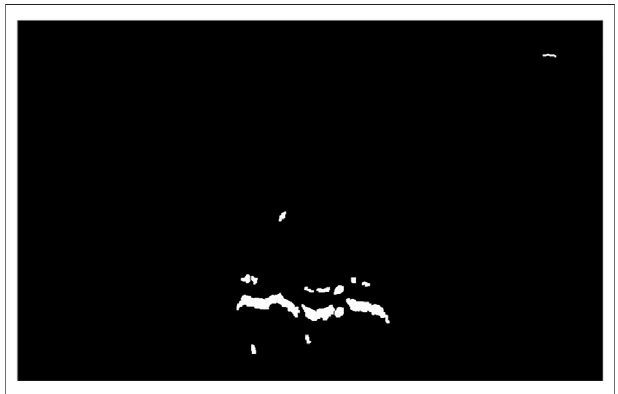
FIGURE 7 | Binary image after fi ne length check processing of the connected region.